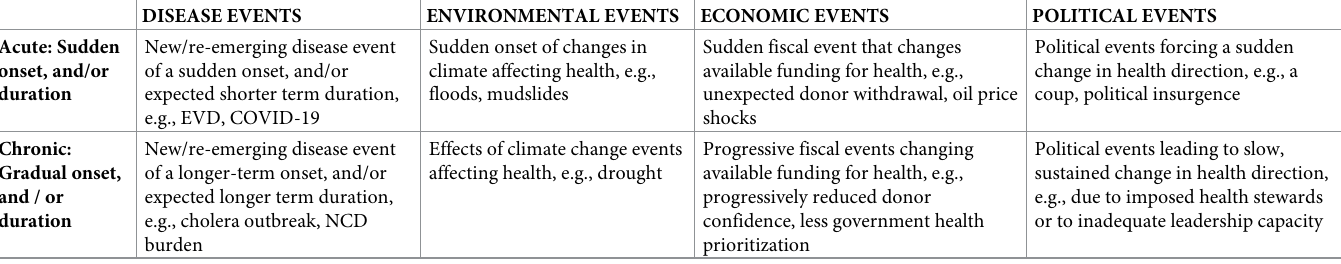
Table 1. Shocks to health systems that hinder provision of essential services in WHO African Region. DISEASE